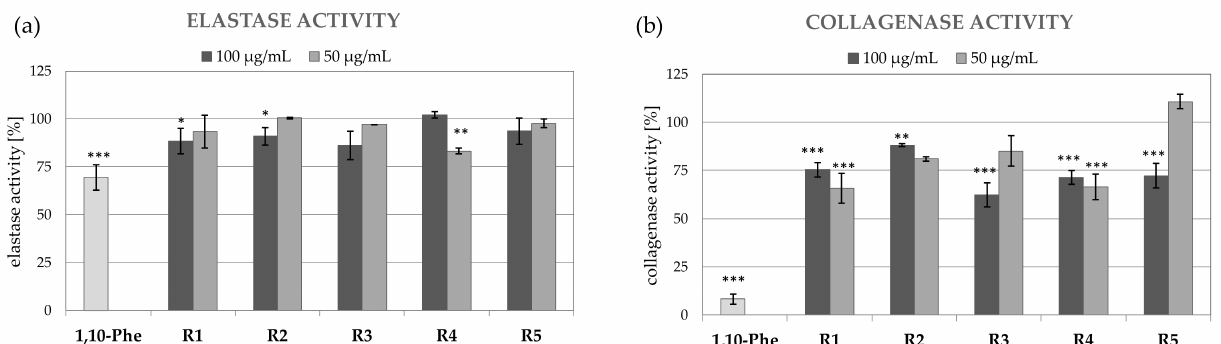
Figure 2. Elastase ( a ) and collagenase ( b ) inhibitory activity of R1–R5 extracts from various parts of R. platyacantha, 1,10- phenantroline (1,10-Phe) was used as inhibitor control; values on graphs represent means ± SD ( n = 3), *** p < 0.001, ** p < 0.01, * p <